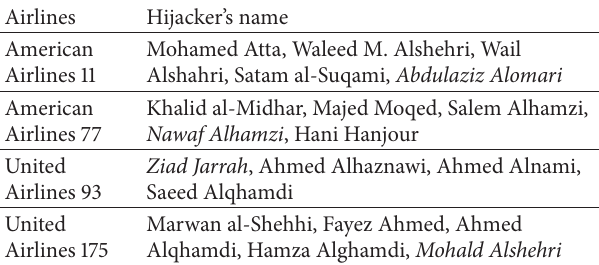
Table 2: The hijackers on different